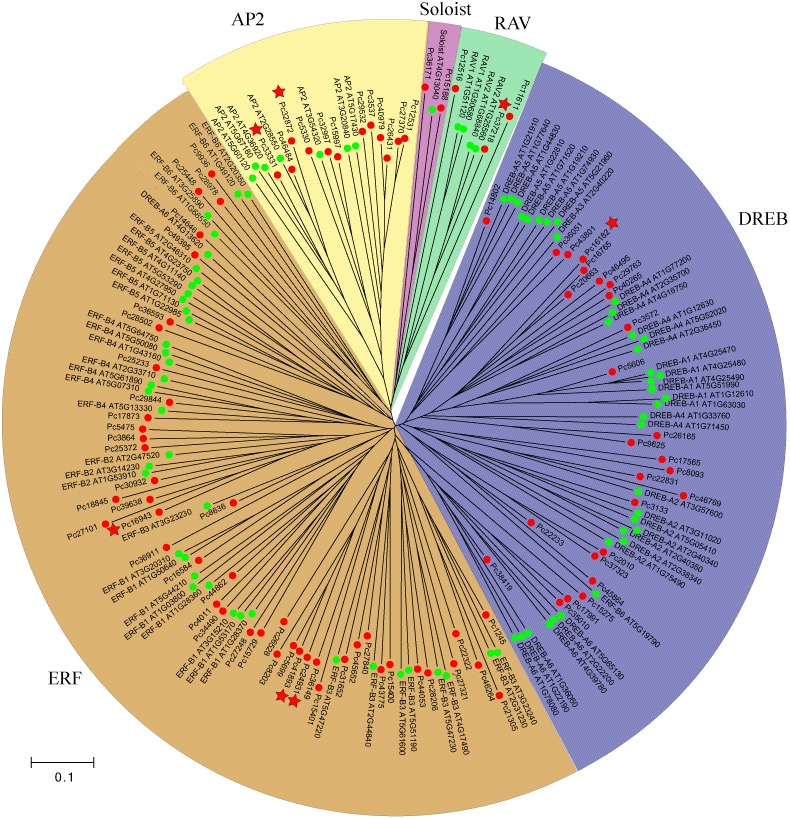
Phylogenetic tree of all AP2/ERF transcription factors from parsley and Arabidopsis.All the circles represent the AP2/ERF genes in parsley (red) and Arabidopsis (green). The red pentagrams represent the AP2/ERF genes which were selected to detected response to four abiotic stresses.